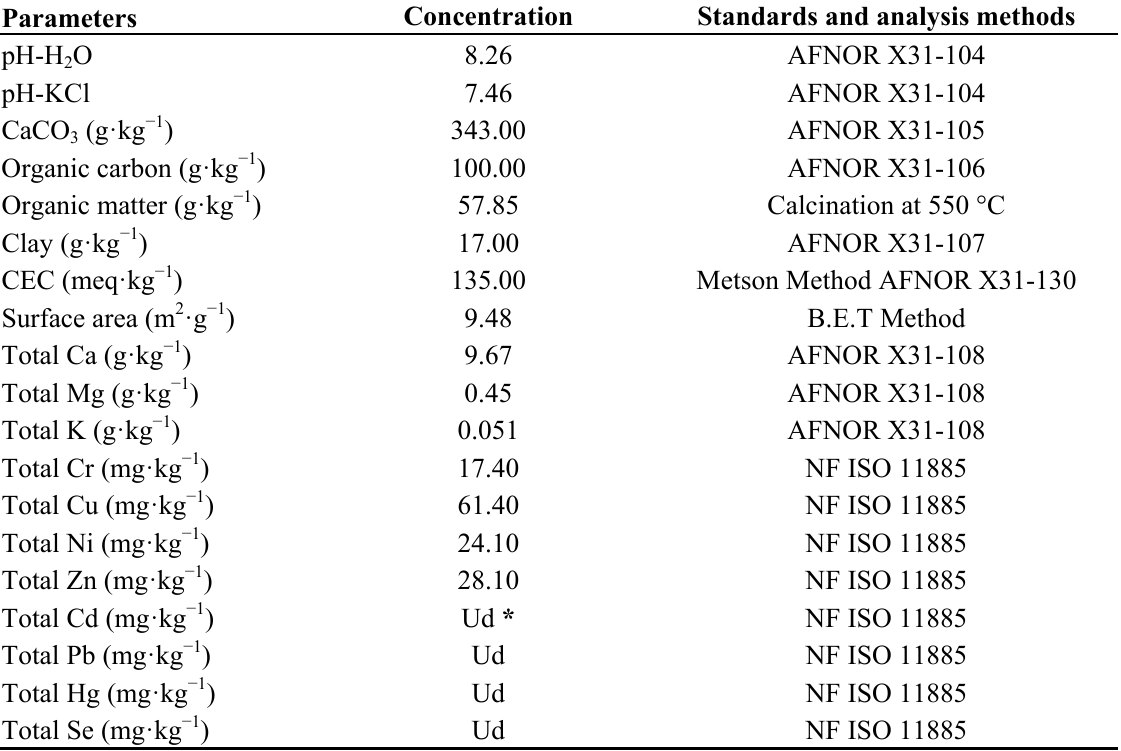
Table 1. Physicochemical characteristics of soil from Cul-de-Sac plain